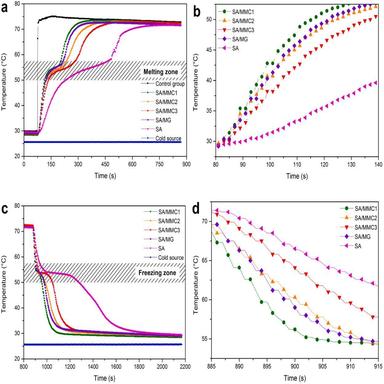
Temperature-time curves of SA, SA/MG, and SA/MMCs: (a) (b) in heating; (c) (d) in cooling.